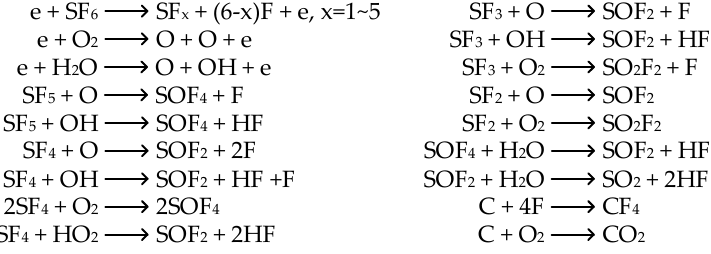
Figure 7. Formation process of SF 6 decomposed components.